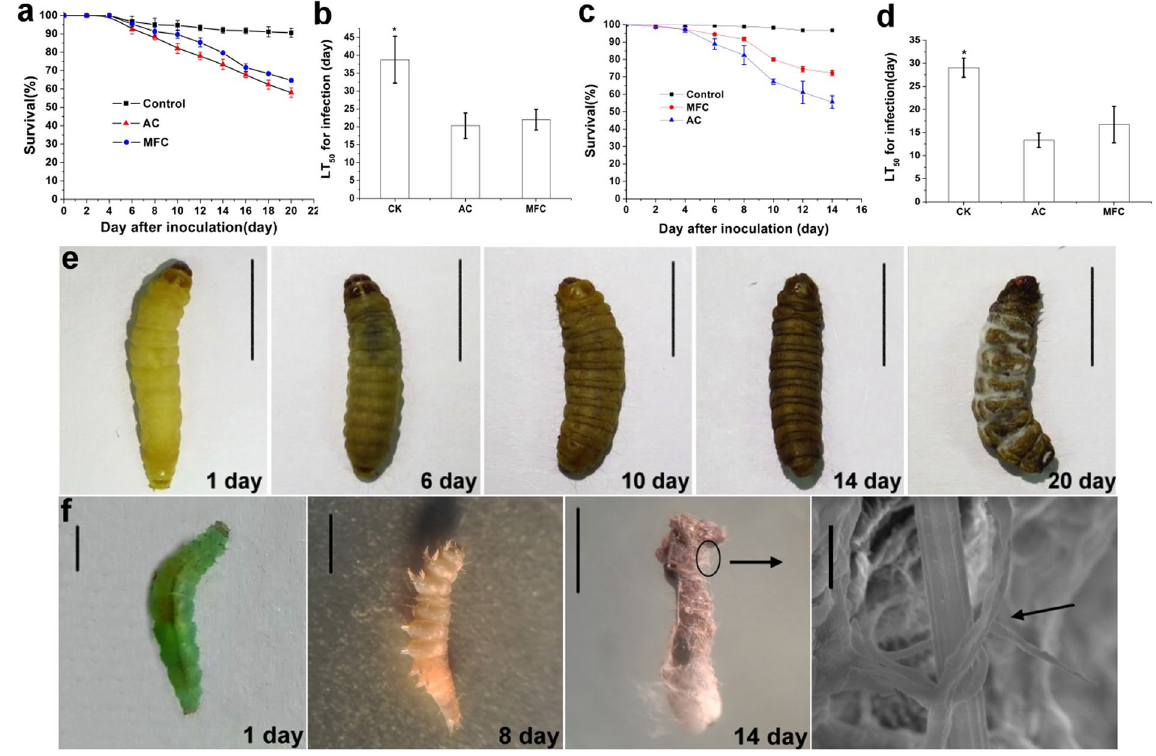
Figure 6. Insect bioassays. ( a ) Bar graph quantifying of survival rate of Galleria mellonella after application of AC and MFC of Hirsutella satumaensis . Relative mortality (relative to the mortality of control group, 9.43%) following application of AC (32.6% ± 1.95%) was significantly different ( p < 0.05) than that upon infection with MFC (25.9% ± 1.50%). ( b ) LT 50 for inoculation assay of G. mellonella . Compare with MFC, LT 50 of AC is shorter though with no significant difference between them. ( c ) Bar graph quantifying of survival rate of Pyrausta xylostella after application of AC and MFC. P. xylostella was more sensitive to H. satumaensis , the lethality reaching 45.11% ± 3.528% (AC) and 27.45% ± 5.507% (MFC) respectively comparing with the control group (the mortality with 3.33%) after 14 days of inoculation. ( d ) LT 50 for inoculation assay of P. xylostella . The LT 50 between AC and MFC show more difference though not reaching a significant level at 0.05. ( e ) Shows cuticles change of G. mellonella after treatment 1 day, 6 day, 10 day, 14 day and 20 day. The cuticles of G. mellonella larvae change from gray to brown after infection and hyphae and conidia producing on cadaver surface at last. Bar = 1 cm. ( f ) Shows cuticles change of P. xylostella after treatment 1 day, 8 day and 14 day. The last one is the insect covering with hyphae and conidiogenous cell of H. satumaensis under SEM. The bar of insects = 2 mm; bar of SEM = 10 μ m. Statistical analysis was performed using a one-way ANOVA. Error bars are standard deviations of three trials and panels are representative of at least 2 independent experiments, * p <